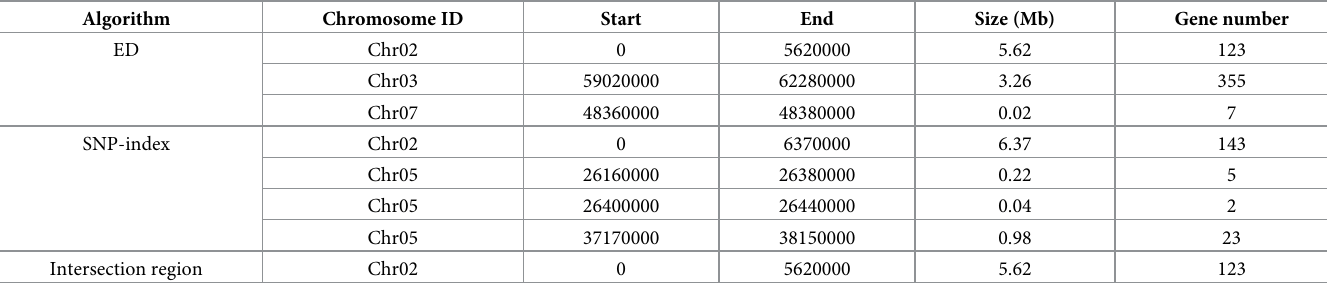
Table 1. Statistics table for ED algorithm and SNP-index algorithm association regions.